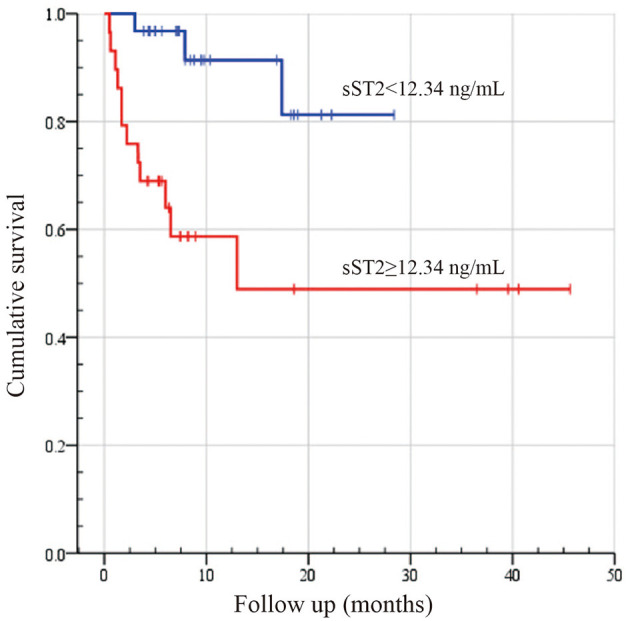
Kaplan–Meier survival analysis between high and low sST2 levels in patients with systemic light-chain amyloidosis. Survival analysis results were compared by employing the log-rank test. Log-rank: P < 0.002.